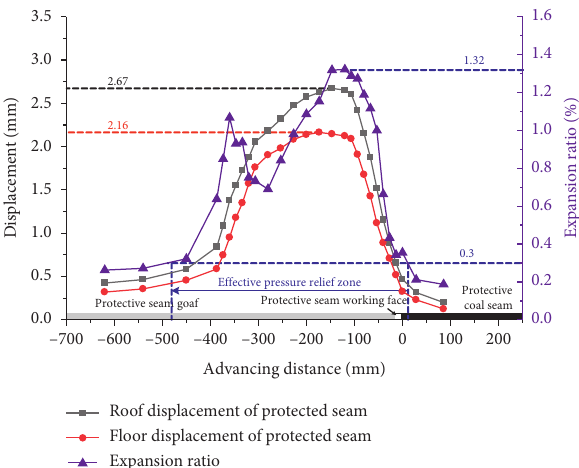
Figure 23: Change curve of protective layer expansion